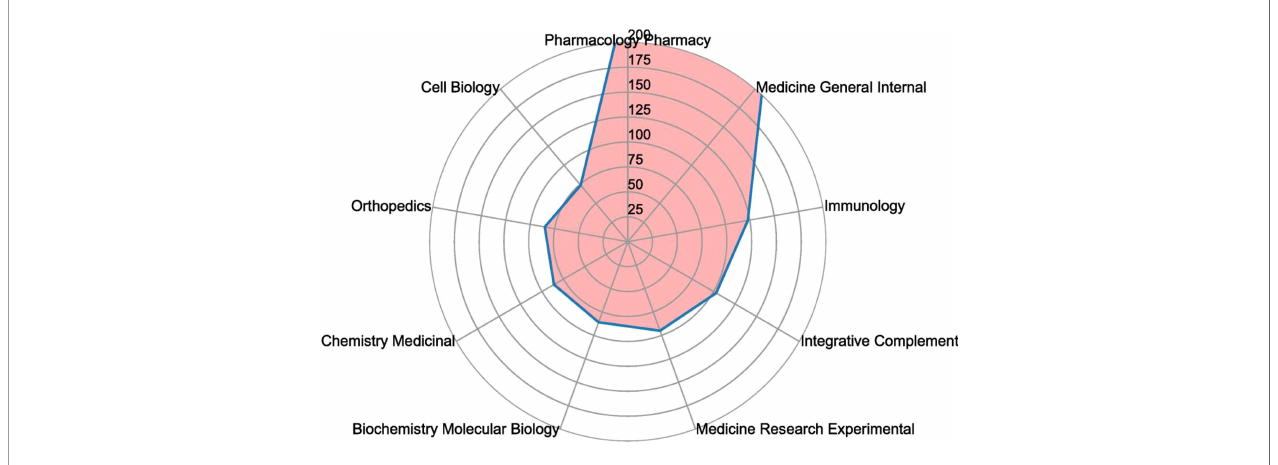
FIGURE 6 | Radar map of the top ten research productive categories on